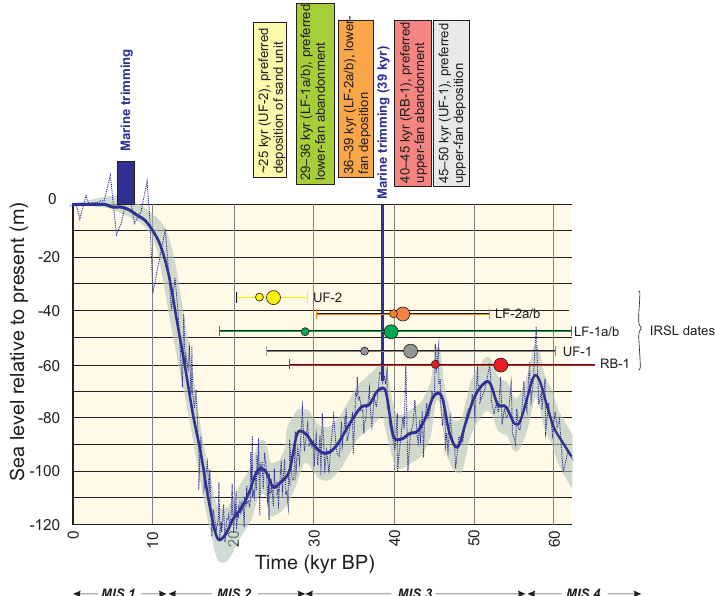
Figure 9. The IRSL chronology of the geomorphic features at Domata plotted against a simplified version of the global sea-level curve after Siddall et al. (2003). The shaded zone in the background represents the stated error range of Siddall et al. Large filled circles represent means of IRSL dates, small filled circles represent medians and the bars are error bars (at 1 σ ). The geomorphic event sequence described in the text is shown above the figure and the favoured of three alternative high sea-level stands within MIS 3 to have trimmed the upper-fan surface is identified with a solid vertical blue line at